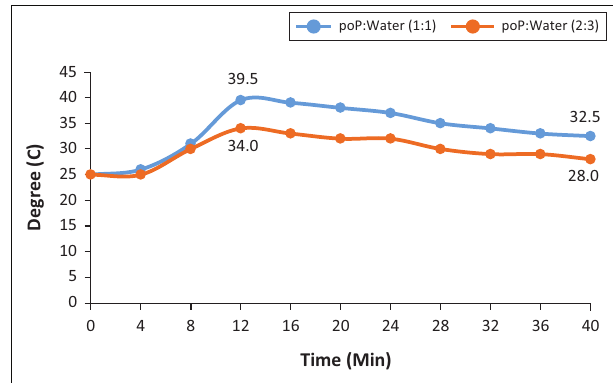
FIGURE 10: Virgin temperature changes.